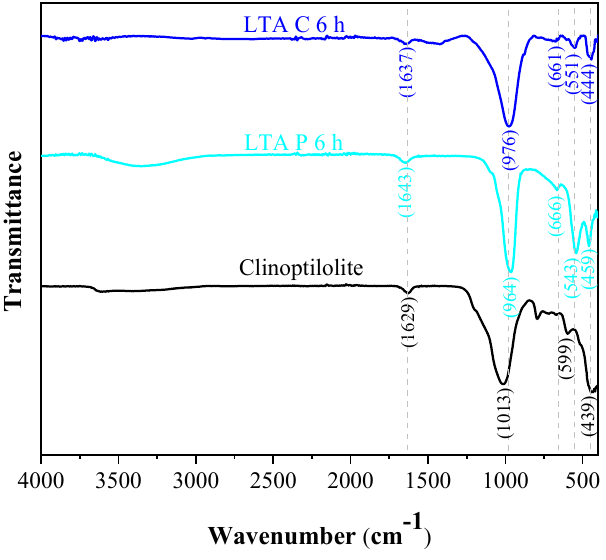
Figure 7. FTIR spectra of clinoptilolite and the LTAP6h and LTAC6h zeolite samples.